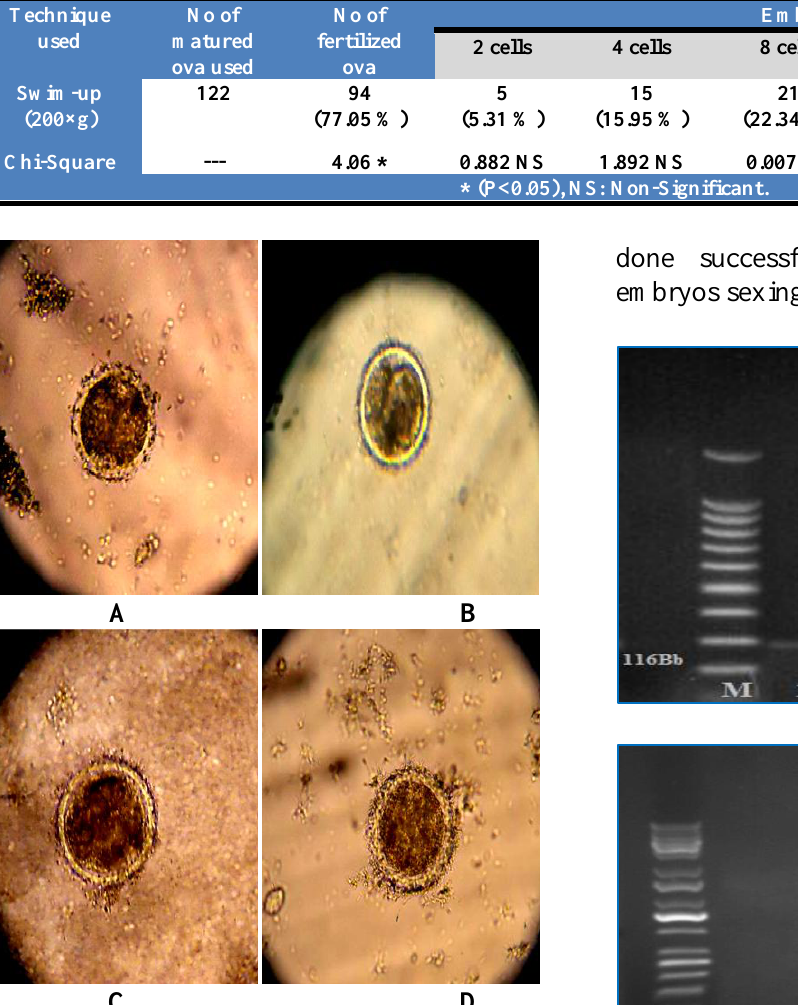
Table, 3: Number of goat embryos obtained by IVF using sperms selected by swim-up or ficoll density techniques after centrifugation at 200×g and according to their stage of development.